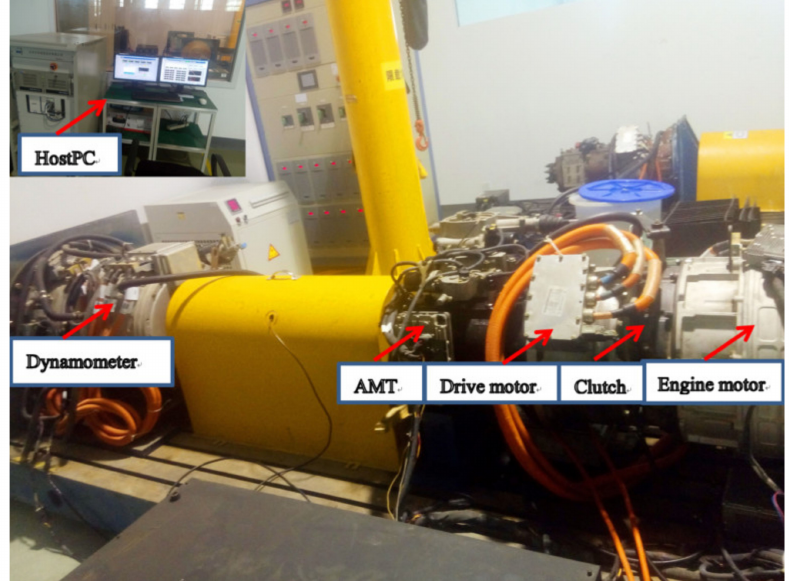
Figure 16. Test bench for the single-axis parallel hybrid